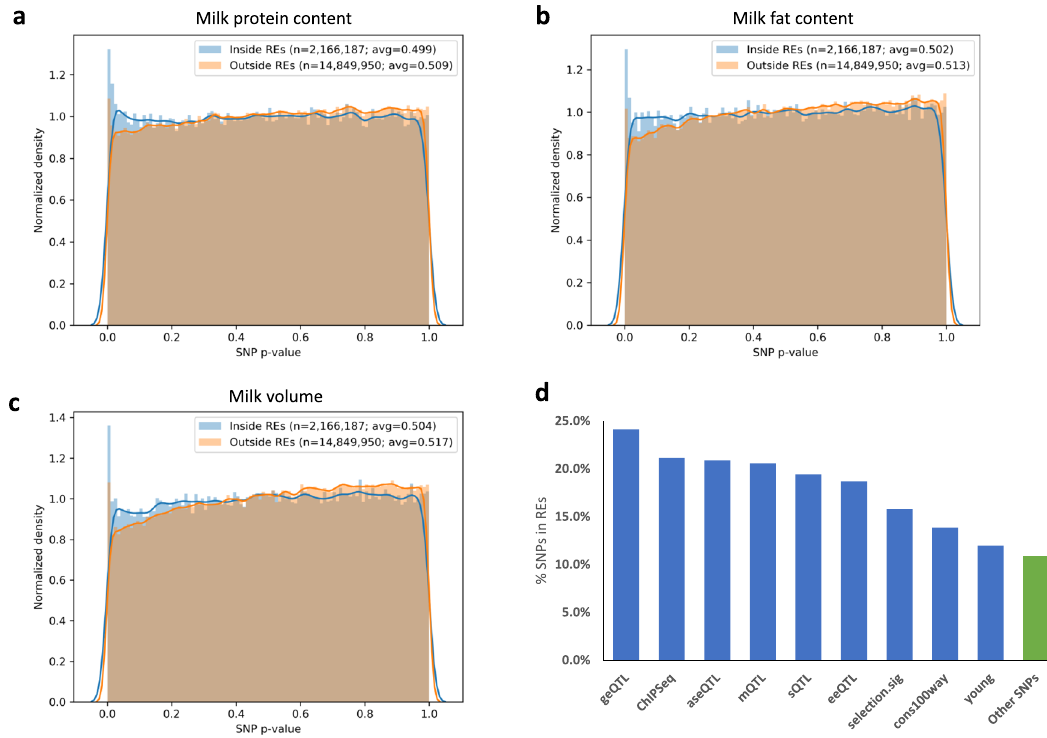
Fig. 5 Overlap with dairy cattle GWAS SNPs. a – c The distribution of p -values from GWAS for milk protein content ( a ), milk fat content ( b ), and milk volume ( c ), for SNPs inside and outside of characterized REs in cattle. The p -values were calculated by previous studies from which the SNPs were obtained (citations in text). d The percentage of SNPs in REs categorized as geQTL (gene expression QTL), ChIPSeq (SNPs in ChIP-seq peaks from previously generated H3K4me3 and H3K27ac data from liver, muscle, and mammary gland), aseQTL (allele-speci fi c expression QTL), mQTL (metabolites QTL), sQTL (splicing QTL), eeQTL (exon expression QTL), selection.sig (selection signature between dairy and beef cattle), cons100way (variants under genomic sites conserved across 100 vertebrate species), young (variants that are recently selected), and other SNPs not placed in any of the previous categories. SNPs may belong to multiple